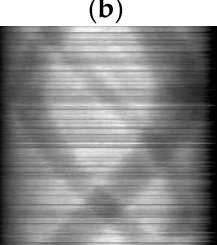
Figure 9. Neutron projection image and sinogram. ( a ) A neutron projection image of the nuclear fuel element from one angular view. ( b ) A sinogram of an axial layer.